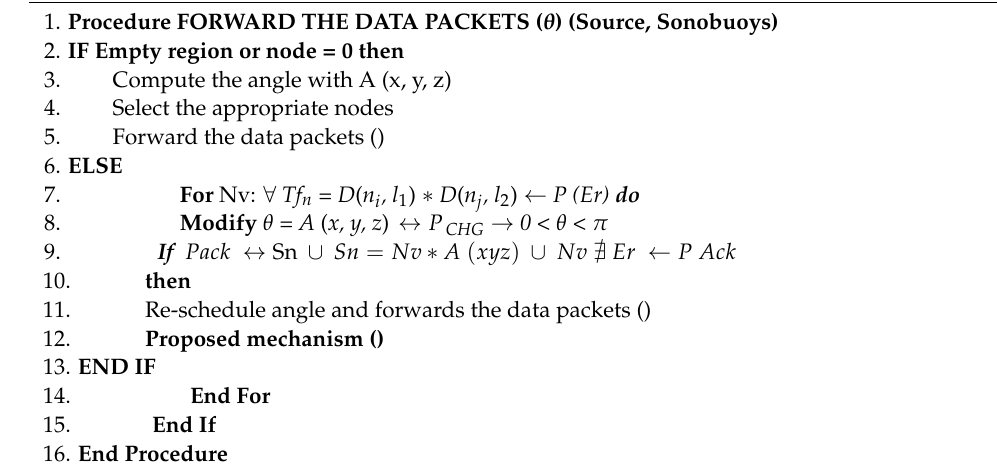
Algorithm 3: Empty Regions Recovery Using Binary